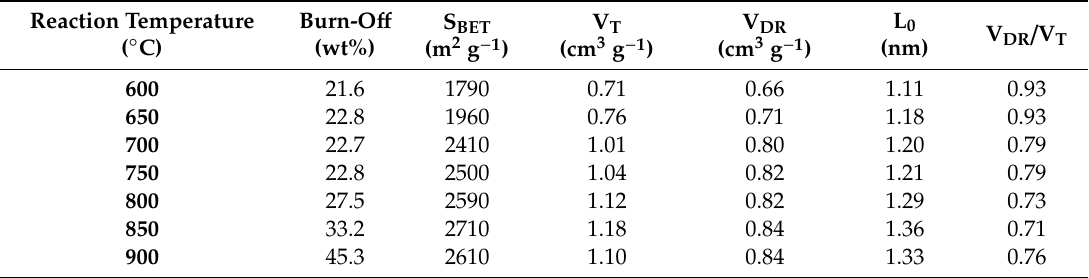
Table 4. Porosity parameters of ACs produced from coal-tar mesophase by KOH activation (mesophase / KOH ratio 1:3, soaking 2